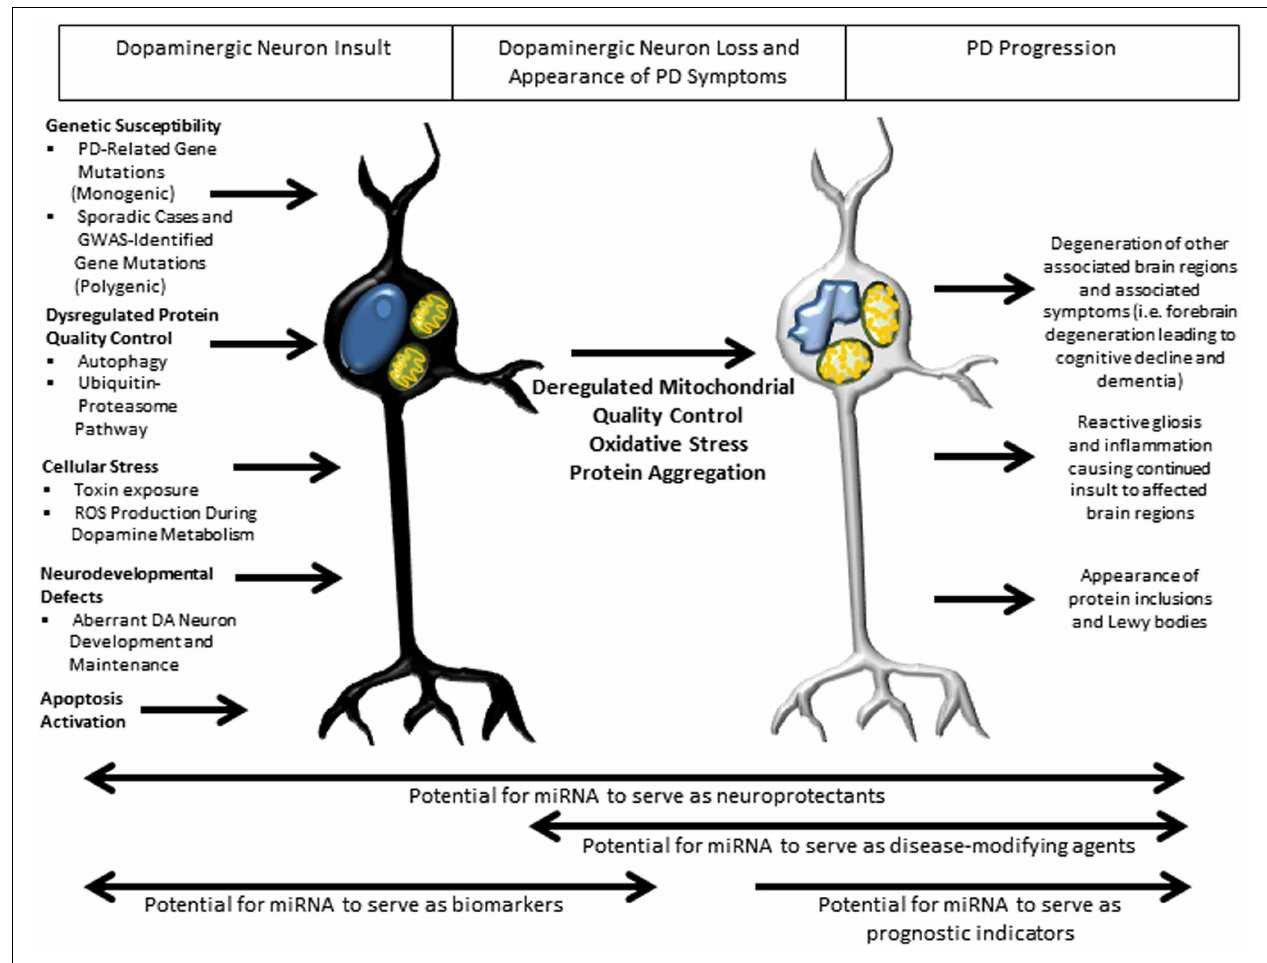
FIGURE 3 | Overview of pathways implicated in PD pathogenesis and potential roles of miRNA in therapy. Several well-studied cellular pathways have now been implicated in PD pathogenesis, with an apparent convergence on mitochondrial damage, oxidative stress and protein aggregation leading to DA neuron death and downstream sequelae of the progressive pathogenic process. In the earliest stages of insult, miRNA may